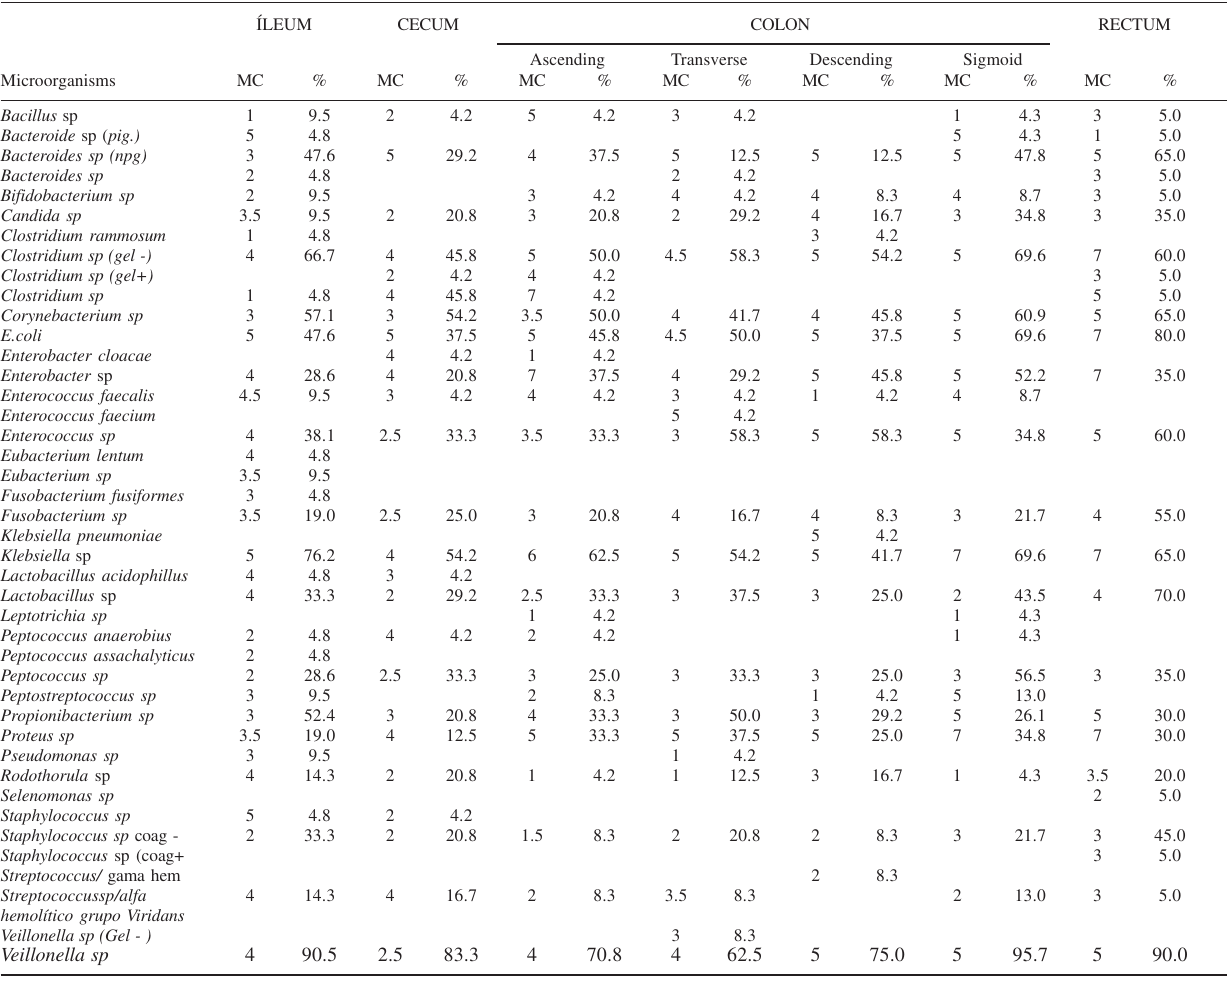
MC = Mean concentration (UFC / Log ), % = prevalence 10 Table 5 - Association between microorganisms/sites of the lower digestive tract Microbiota Lower Digestive Tract site Klebisiella sp, Clostridium sp (gel-), Veillonella sp